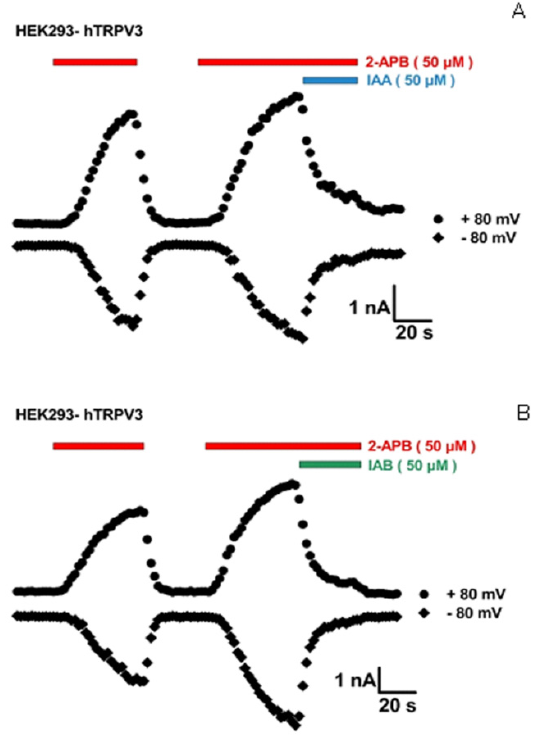
Figure 2. Isochlorogenic acids A and B inhibit TRPV3-mediated current activated by 2-APB. ( A ) Representative hTRPV3 current activated by 50 µ M 2-APB (red bar) before and after its coapplication with 50 µ M isochlorogenic acid A (blue bar) and washout. ( B ) Representative hTRPV3 current activated by 50 µ M 2-APB (red bar) before and after its coapplication with 50 µ M isochlorogenic acid B (green bar) and washout.